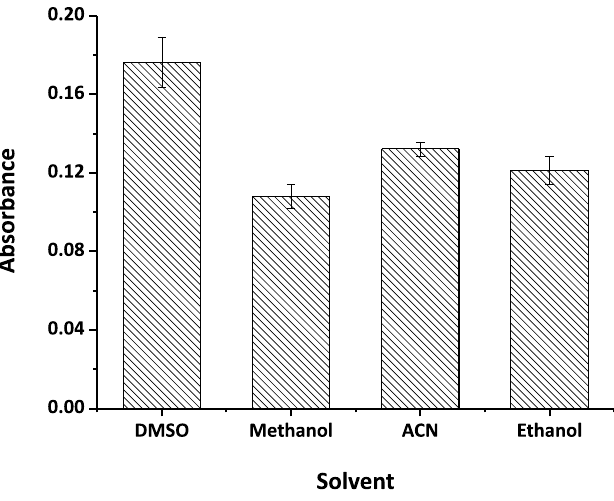
FIGURE 2 - Effect of the solvent on the analytical